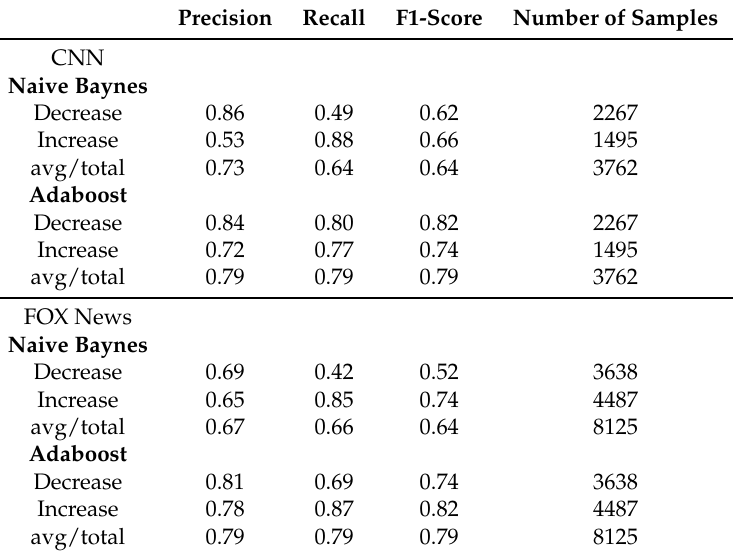
Table 7. Influence ratio prediction—Benign to Light, observed time = 60 min, δ T = 1 min. Precision Recall F1-Score Number of Samples